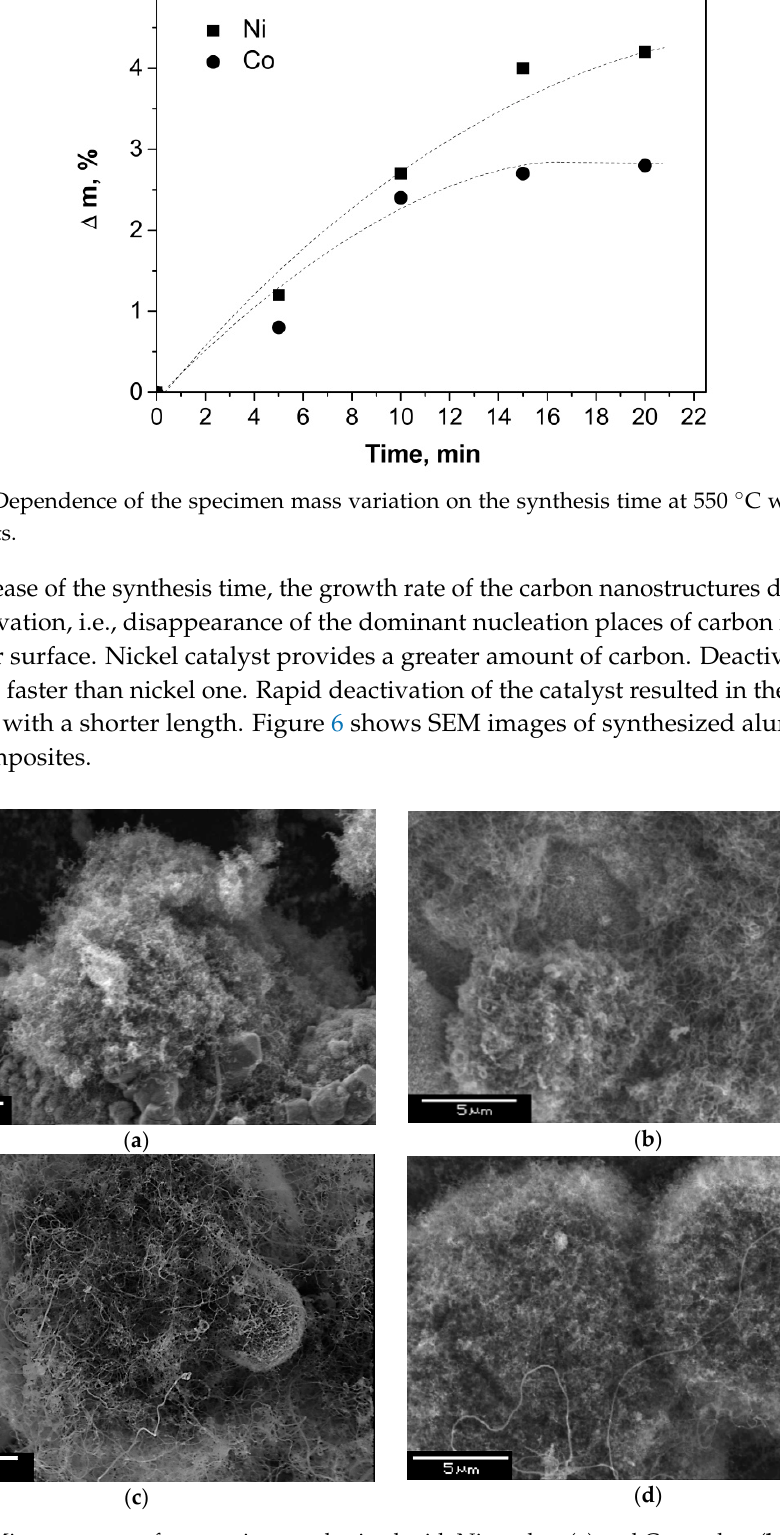
Figure 6. Microstructure of composites synthesized with Ni catalyst ( a ) and Co catalyst ( b ) (synthesis time 10 min) and with Ni catalyst ( c ) and Co catalyst ( d ) (synthesis time 20 min).